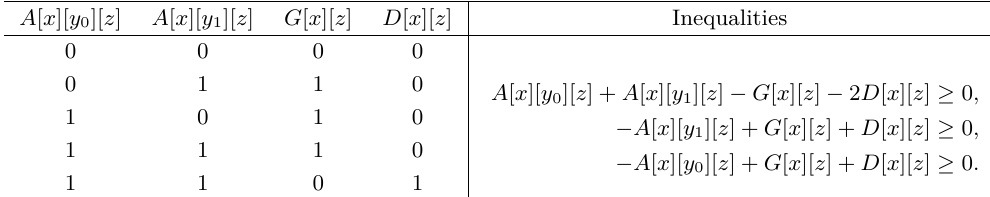
Table 3: Patterns of cube variables through θ and